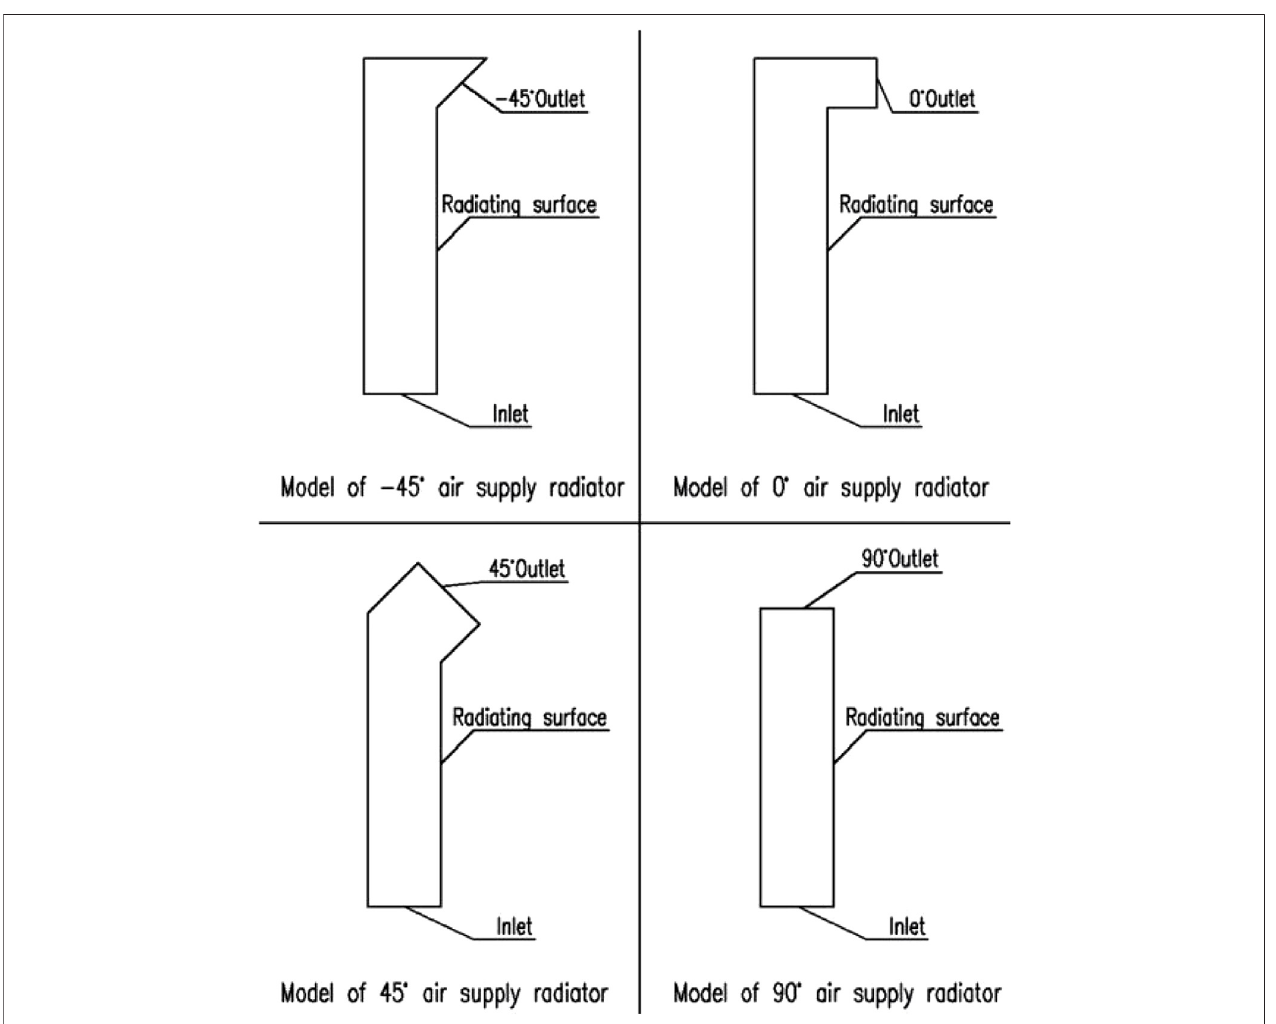
FIGURE 6 | Geometric model of the radiator at different